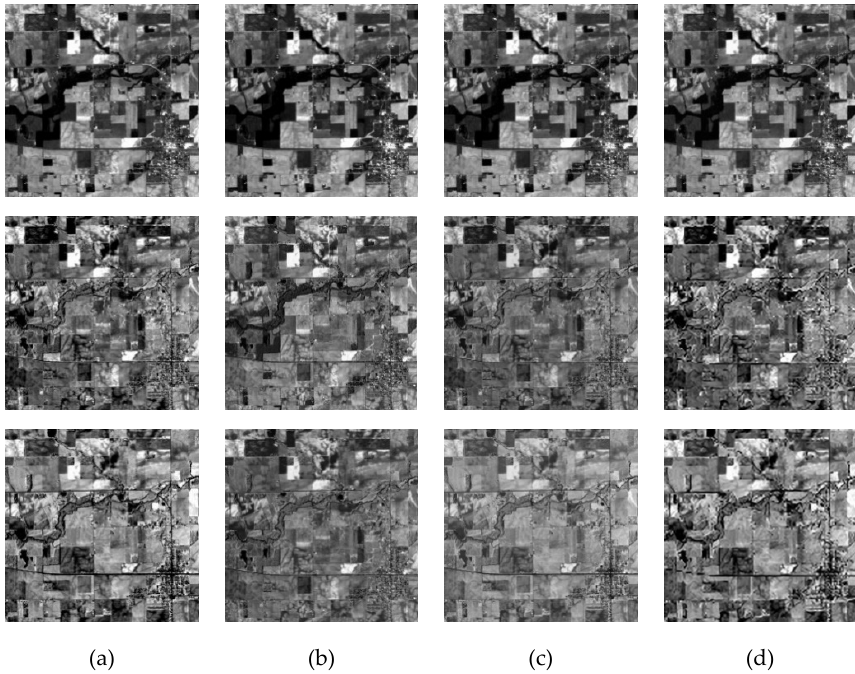
Table 4. Spectral assessment of our proposed method and spectral resolution enhancement methods on Cuprite dataset.